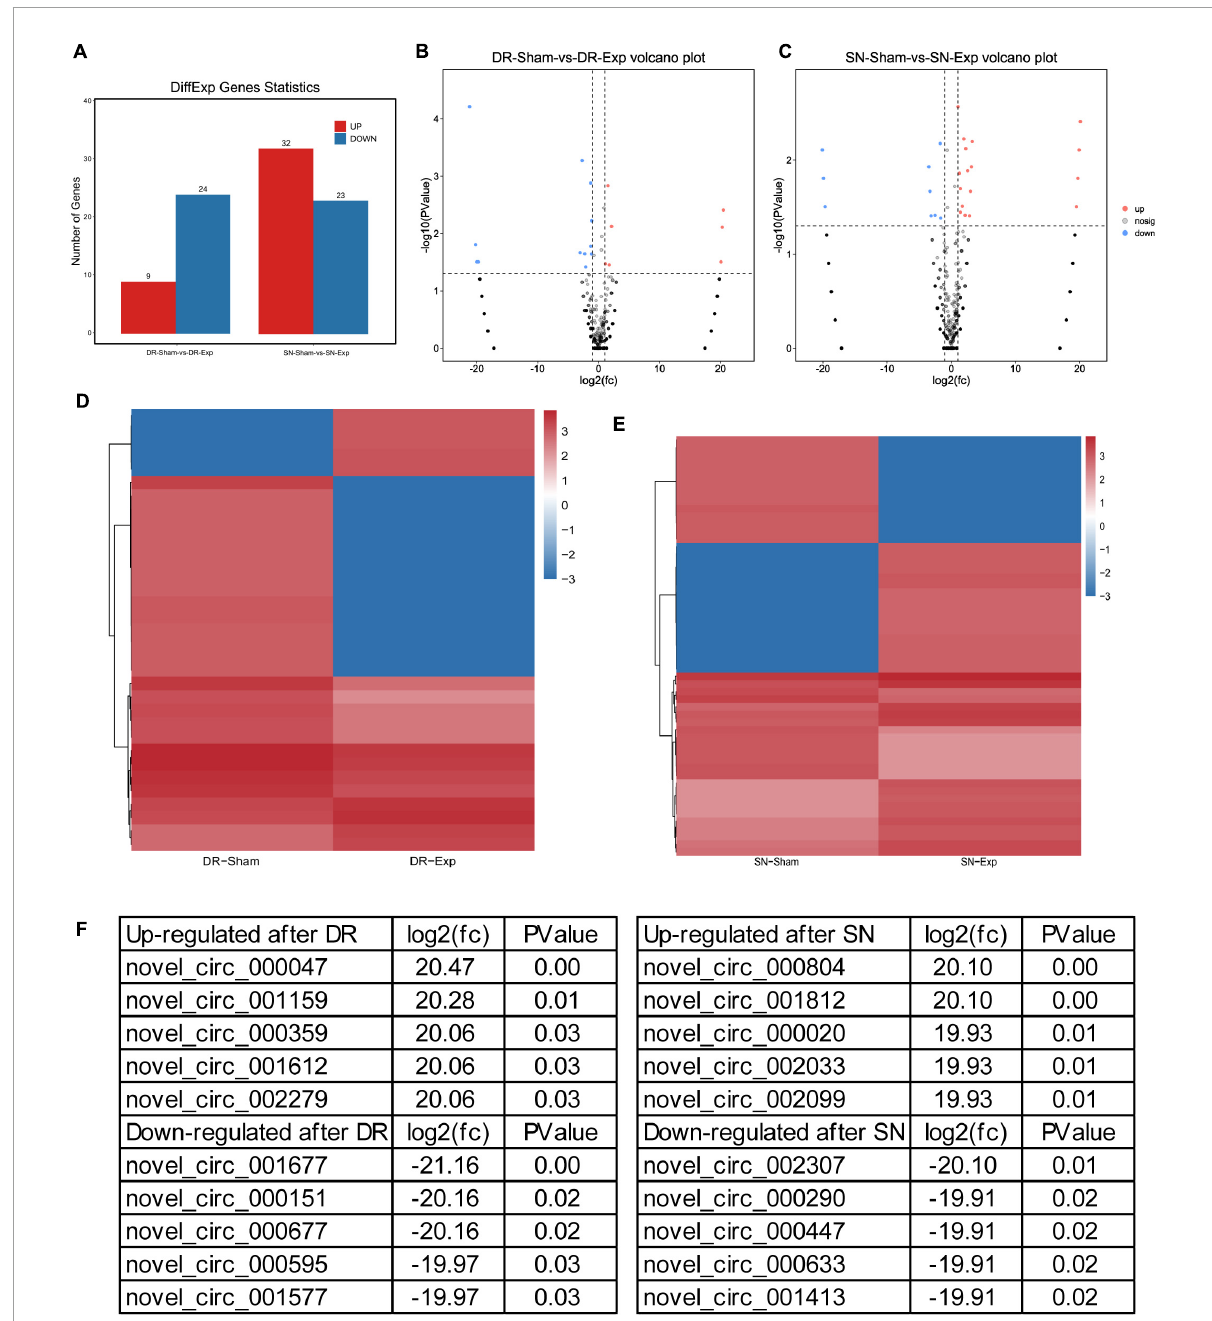
FIGURE2 Changes of circular RNAs after rat central and peripheral axon injuries. (A) Numbers of differentially expressed circular RNAs after rat central and peripheral axon injuries. Red indicates up-regulated after nerve injury while blue indicates down-regulated after nerve injury. (B,C) The volcano plots of differentially expressed circular RNAs in DRGs after (B) central axon injury and (C) peripheral axon injury. (D,E) Heatmaps of differentially expressed circular RNAs in dorsal root ganglions (DRGs) after (D) central axon injury and (E) peripheral axon injury. Red indicates relatively high abundance and blue indicates relatively low abundance. (F) Top 5 up-regulated and top 5 down-regulated circular RNAs after rat central and peripheral axon injuries.